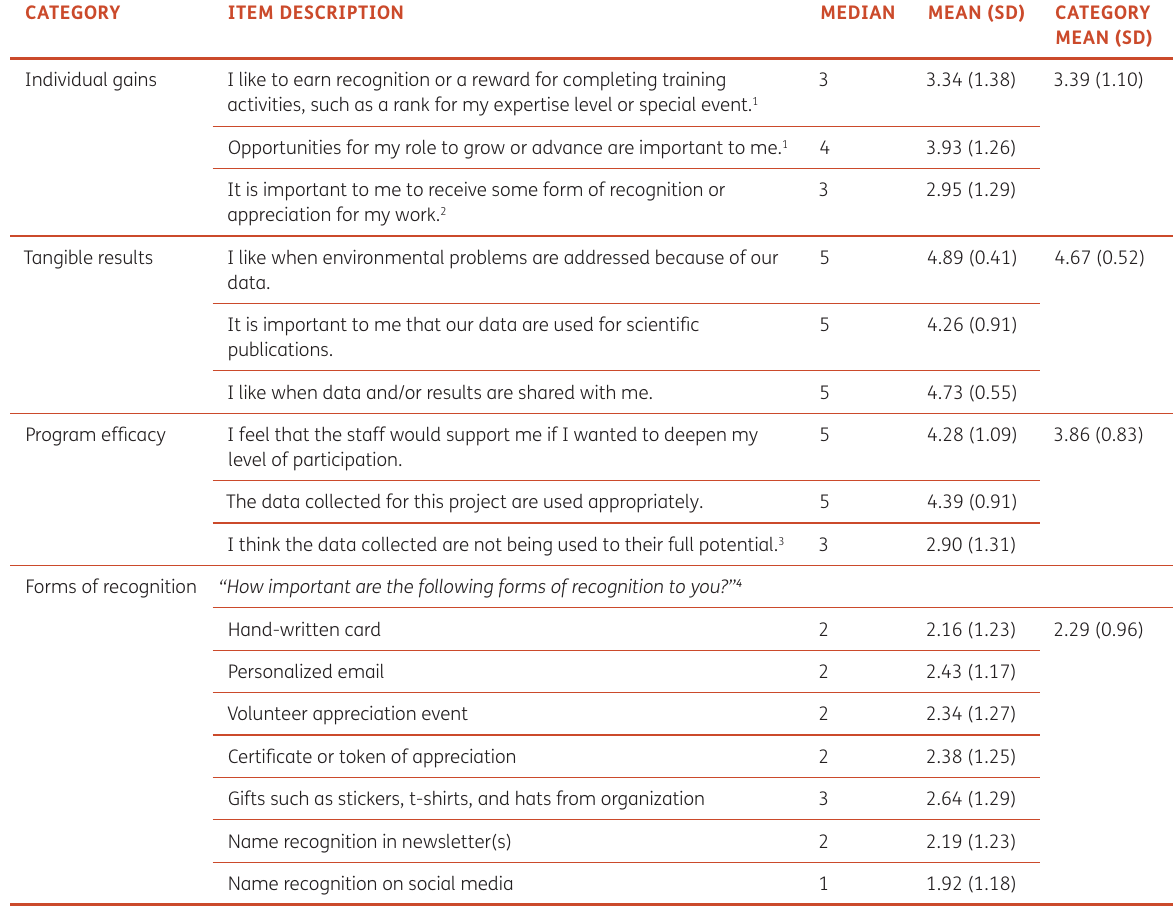
Table 6 Descriptive statistics of organizational factors and forms of recognition.